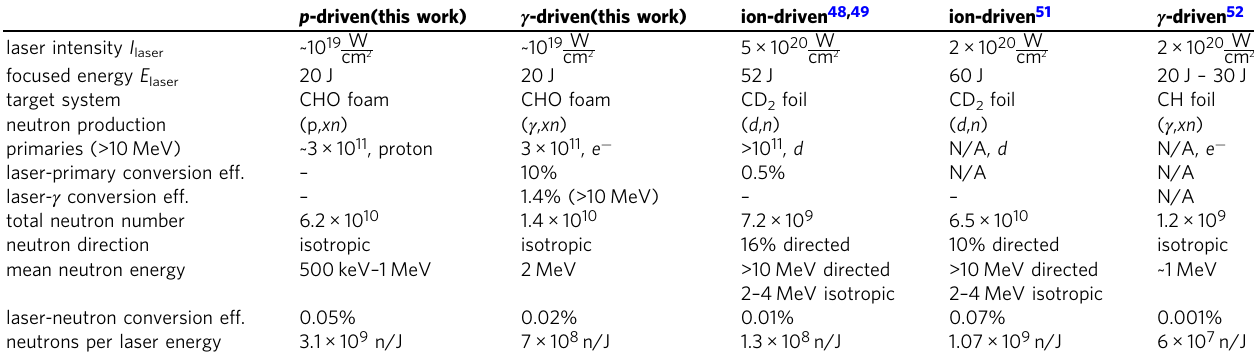
Table 1 Conversion ef fi ciencies. Results from presented work in case of γ -neutron production and proton-driven neutron generation are shown in comparison with previous experiments, where records of neutron generation via laser accelerated deuterons interacting with beryllium catcher 48,49,51 as well as via the electron acceleration to bremsstrahlung to neutron scheme 52 were